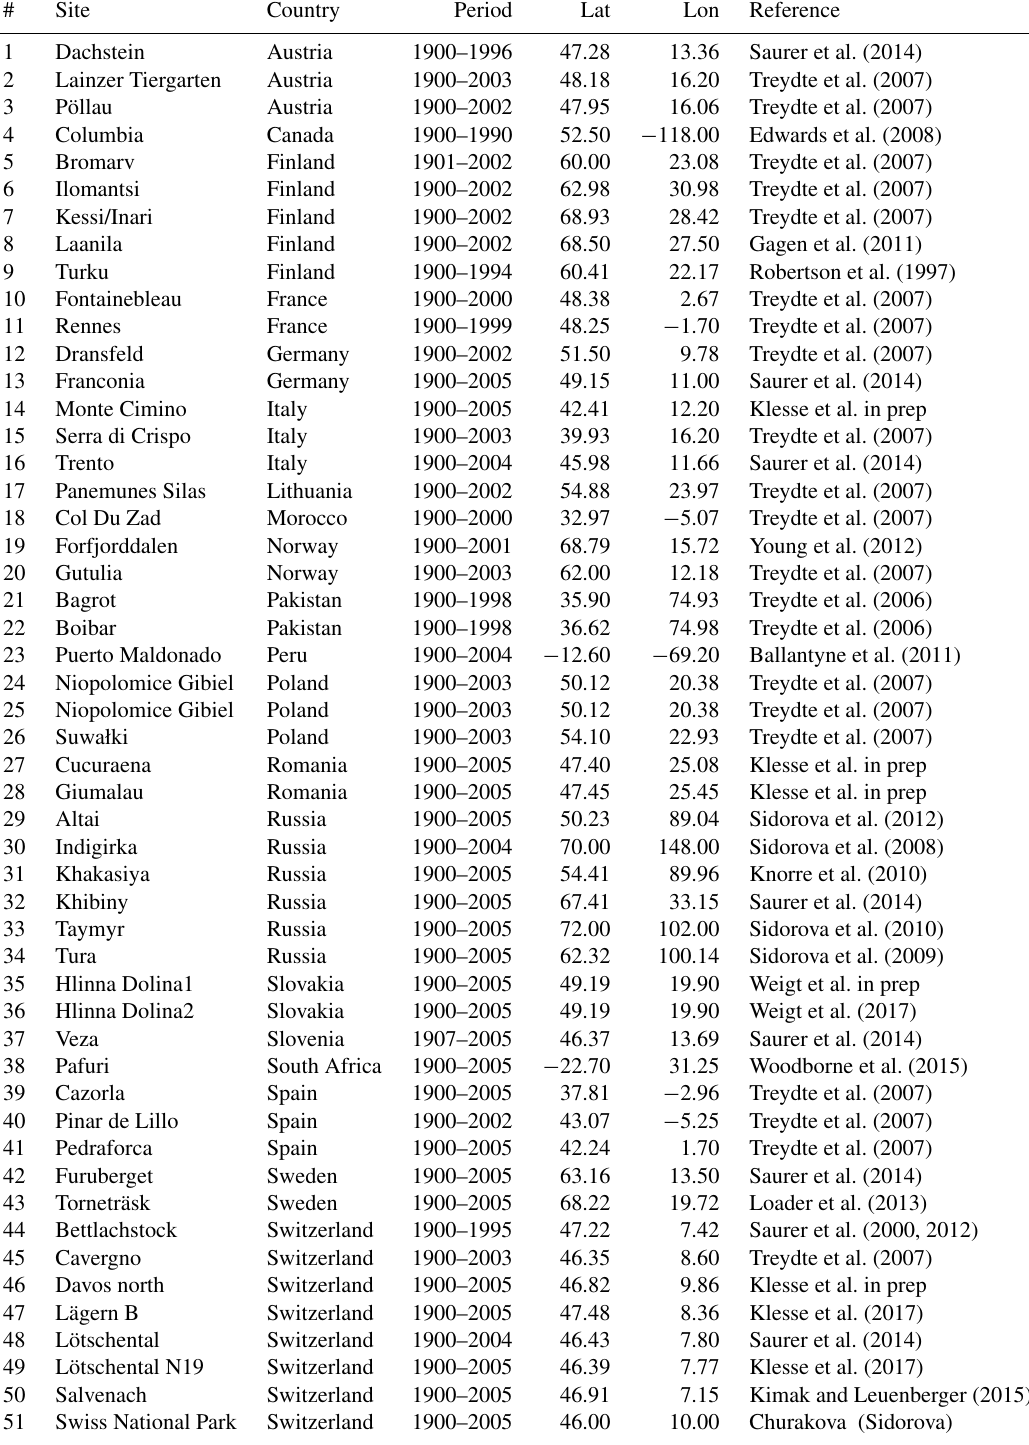
Table A1. δ 13 C tree-ring time series compiled for this